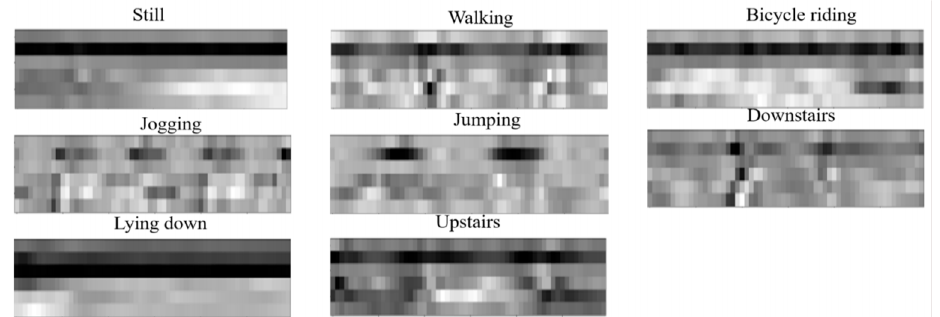
Figure 7. Examples of datasets in grayscale